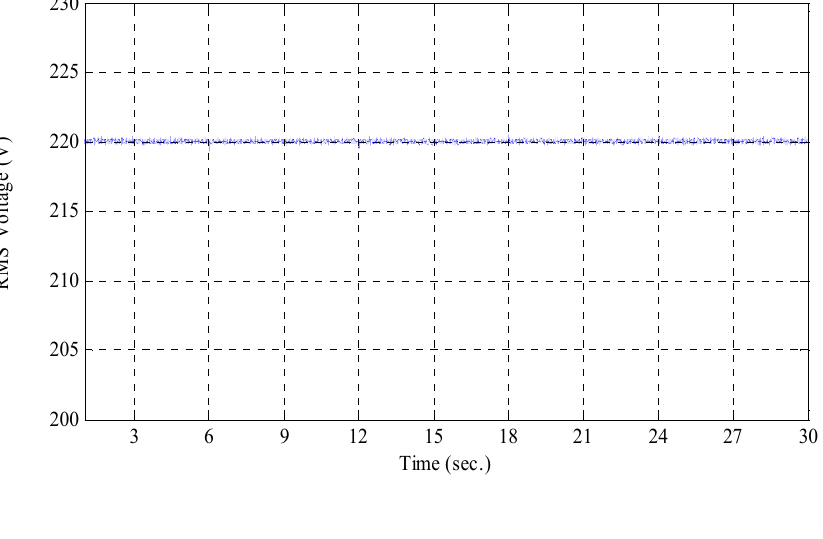
Figure 19. RMS value of the output phase voltage